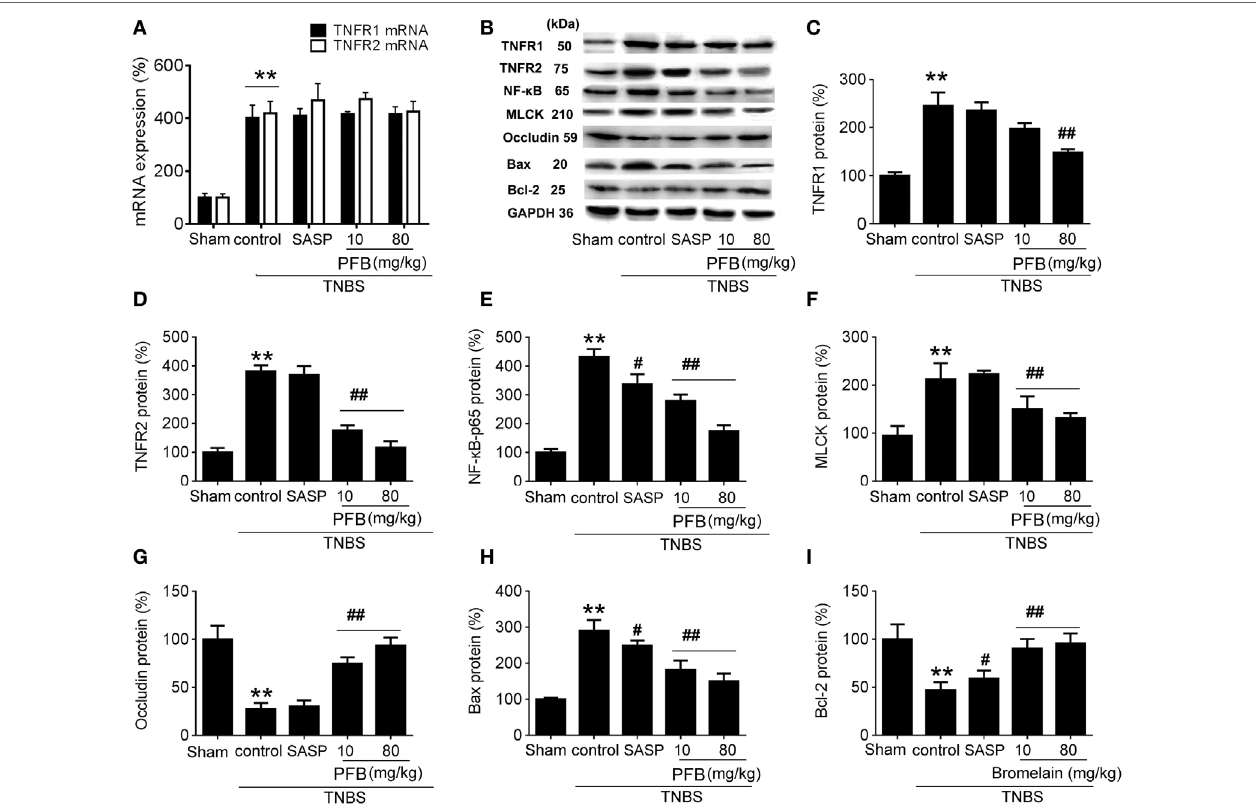
FigUre 5 | Potential mechanisms underlying purified fruit bromelain (PFB) induced therapeutic effects on colitis. Colonic segments were isolated after 14 days of PFB treatment. Quantitative real-time PCR analysis of TNF- α receptor (TNFR) mRNA (a) ; Western blotting analysis of TNFR protein (B–D) , inflammation marker NF- κ B (B,e) , tight junction barrier related protein myosin light chain kinase (MLCK) (B,F) and (B,g) , apoptosis-related proteins Bax (B,h) and Bcl-2 (B,i) . Data are expressed as the mean ± SD. Values in the sham group are set to 100% and other values are given relative to those in the sham group: ** P < 0.01 compared with sham group; # P < 0.05 and ## P < 0.01 compared with TNBS control group ( n = 6